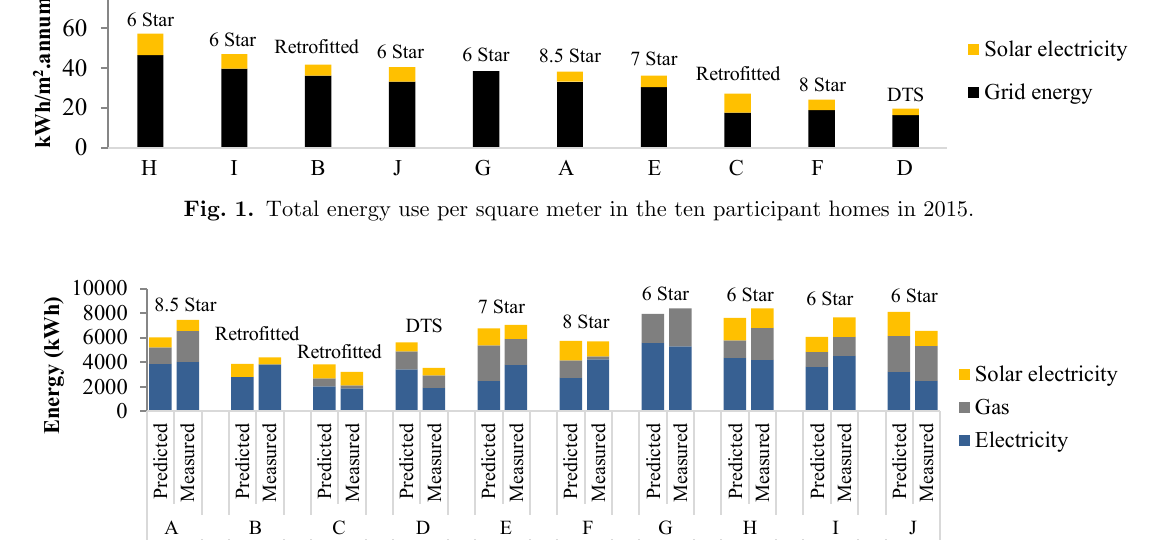
Fig. 2. Total energy prediction per year using eToolLCD compared to the total measured operational energy used in participant households during